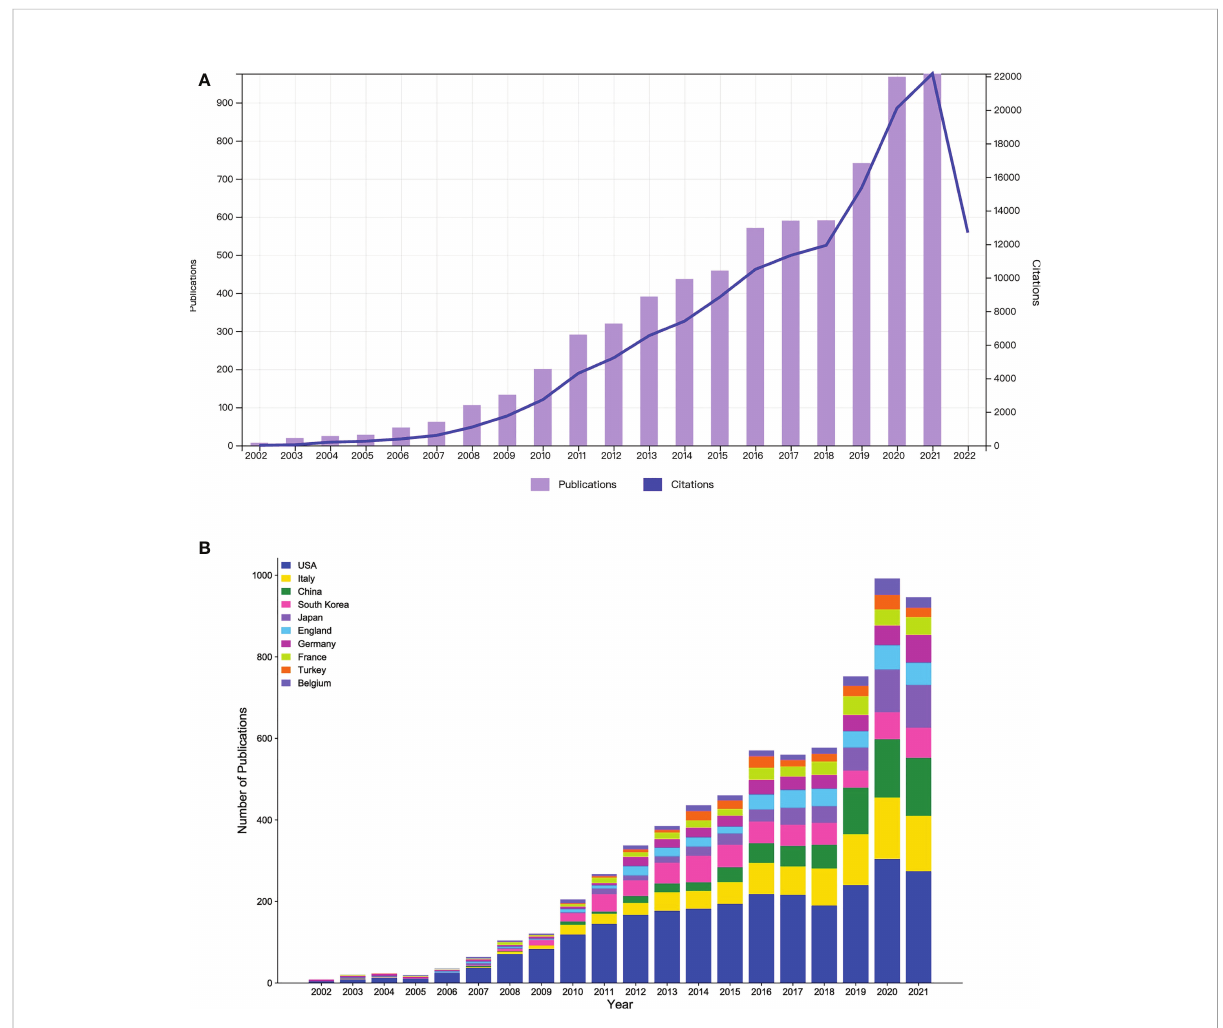
FIGURE 1 (A) The number of annual publications and citations on robotic surgery in oncology from 2002 to 2021. (B) The number of annual publications in oncology robotic surgery in the top 10 countries/regions between 2002 and